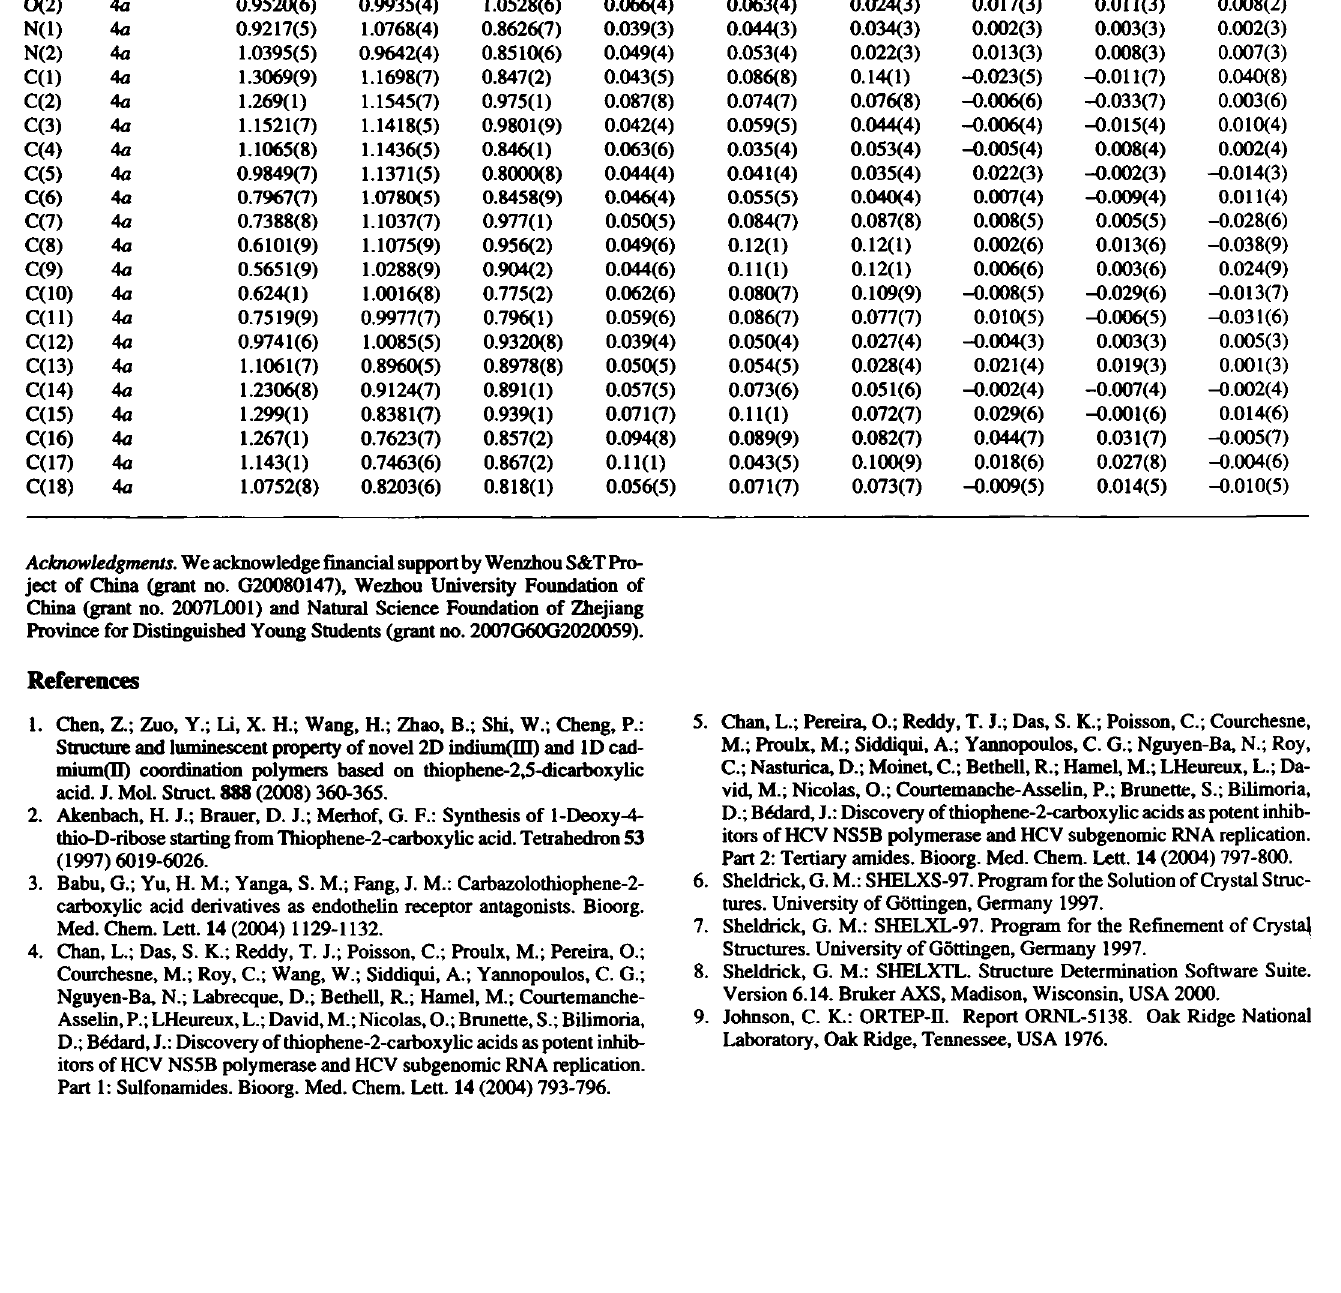
Table 3. Atomic coordinates and displacement parameters (in Â 2